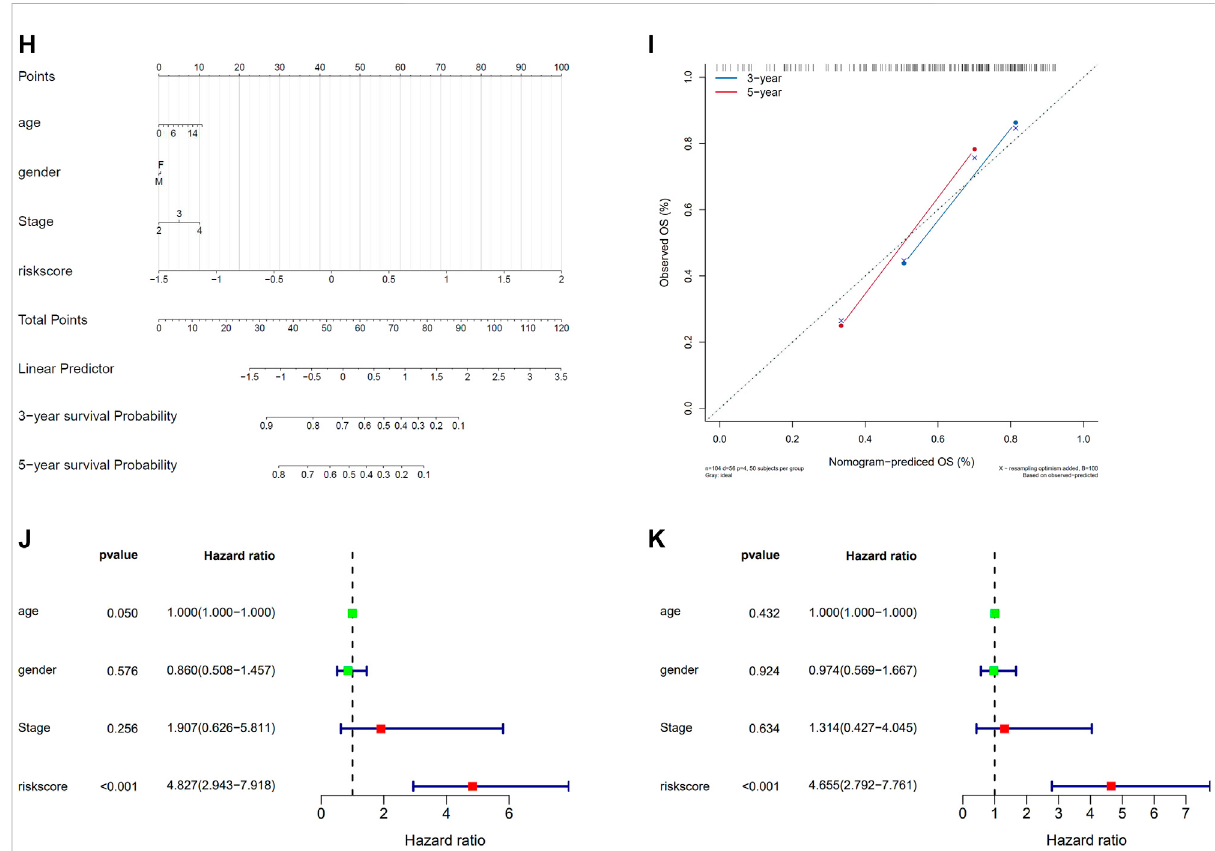
FIGURE 2 Lassoanalysisandmodelconstruction. (A) LASSOcoef fi cientpro fi lesofthe13IRGsinTARGET-NBL; (B) Acoef fi cientpro fi leplotwasgenerated against the log (lambda) sequence. Selection of the optimal parameter (lambda) in the LASSO model for TARGET; (C) Lasso Coef fi cient HR; (D) Kaplan-Meier survival curve analysis in the high-risk and low-risk NBL patients in the training subset; (E) Kaplan-Meier survival curve analysis in the high-risk and low-risk NBL patients in the testing subset; (F) time-dependent ROC curve for 1-year, 3-years, and 5-years prediction (training subset); (G) time-dependent ROC curve for 1-year, 3-years, and 5-years prediction (testing subset); (H) the nomogram for predicting the 3- and 5- years OS of NBL patients; (I) the calibration curve of the nomogram for predicting 3- and 5-years OS of NBL patients; (J) Univariate Cox regression analyses in the TARGET cohort NBL patients; (K) multivariate Cox regression analyses in the TARGET cohort NBL